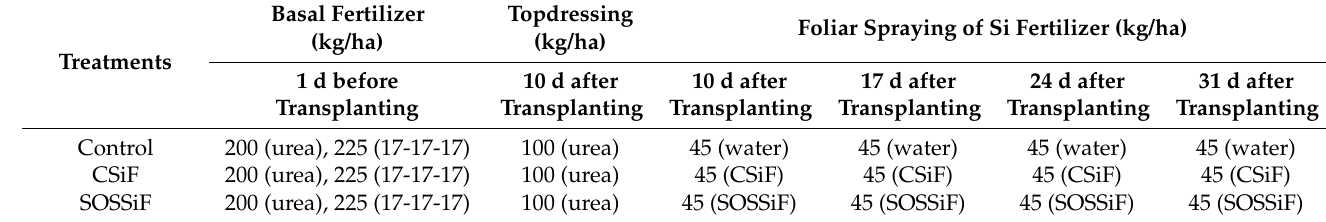
Figure 1. Photos of rice experimental site ( a ) and meteorological data changes in rice growth season ( b ). Table 1. Fertilizer type, application period, and rate used in this